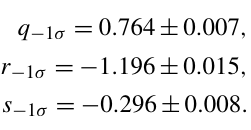
Figure 6. Box plots showing the fraction of the total period of fan activity, T , captured by the span of sampled boulder ages in the artificial-data experiments, a max − a min plotted against the number of sampled ages, n . Each box represents 10000 experiments. As a greater number of ages are sampled, the span of the set of ages is more likely to capture a greater fraction of T , although with di- minishing returns for increasing n . Black lines show exponential regressions corresponding to Eq. (6) and fitted to the mean values (solid) and ± 1 standard deviation